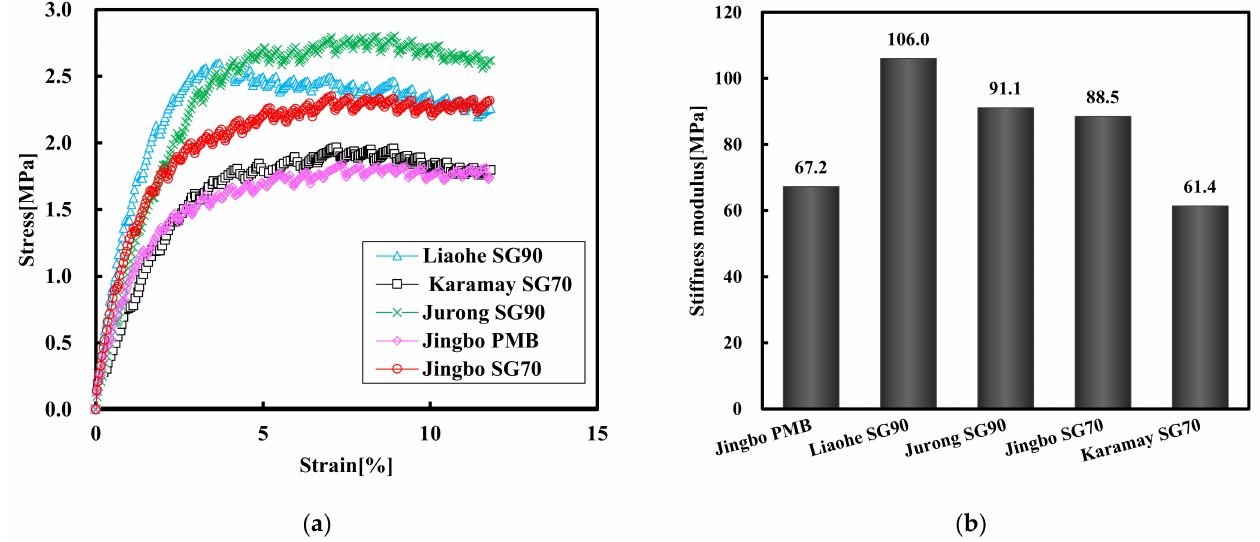
Figure 10. Tensile stress–train curve ( a ) and stiffness modulus ( b ) of five bitumen binders at − 15 ◦ C.